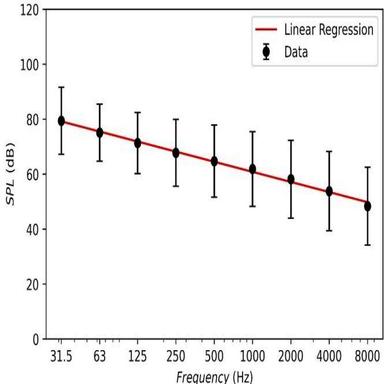
Mean value and standard deviation of the Sound Pressure Level in octave bands for all the analyzed data.